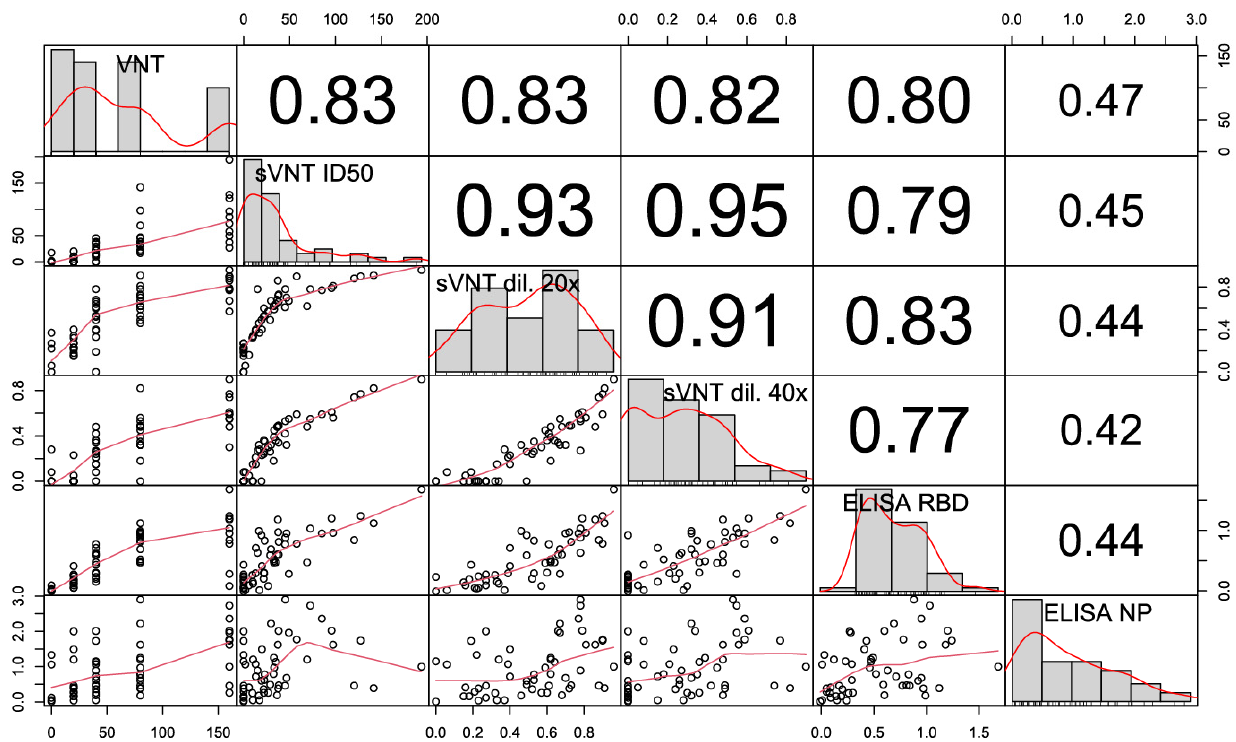
Figure A3. Signal strengths correlation matrix for donor serum samples, tested with various meth- ods. Abbreviations: VNT—threshold serum dilution, corresponding to the 50% plaque reduction;